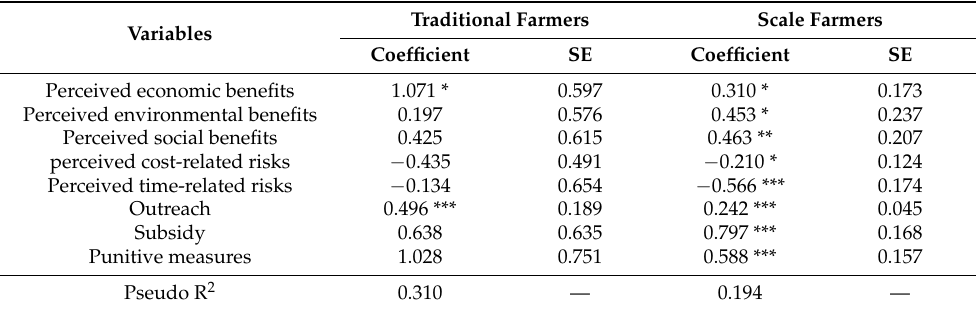
Table 6. The effect of perceived value and government regulation on the willingness to adopt WSI for different scale